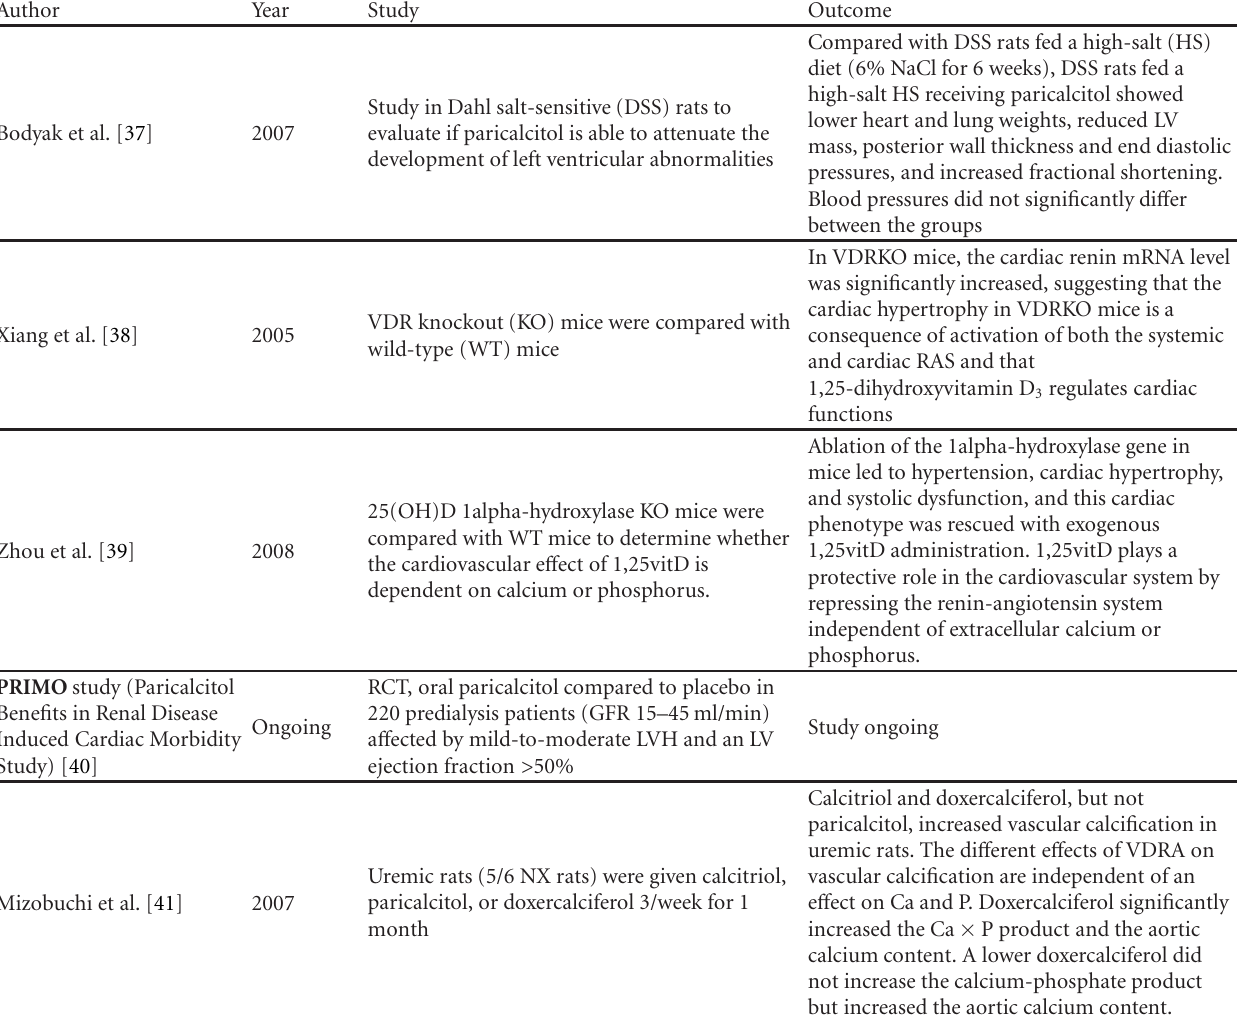
Table 8: Cardiovascular